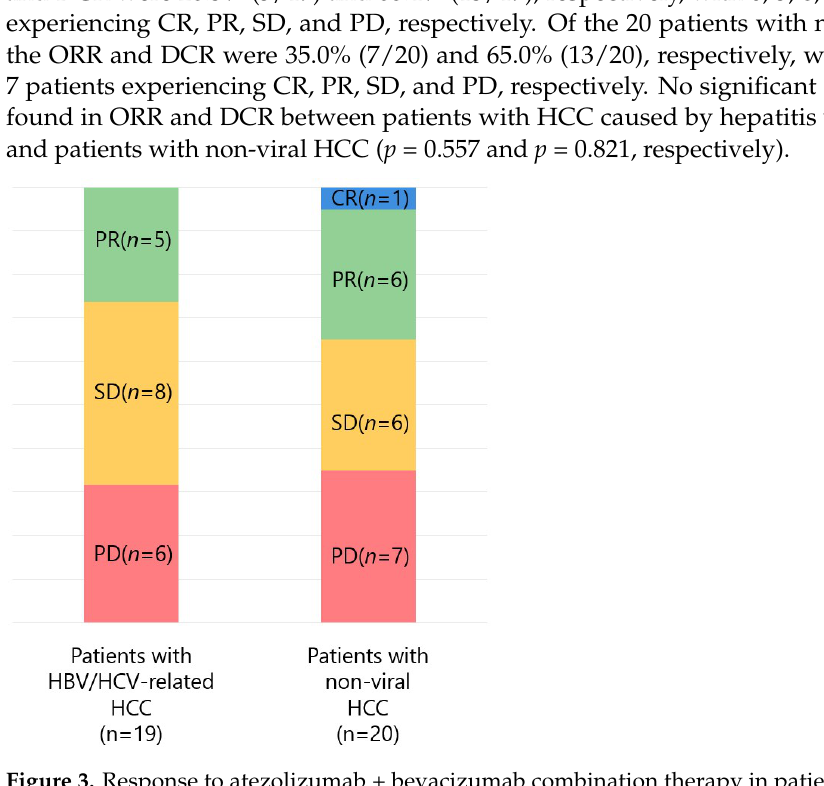
Figure 2. Response to atezolizumab + bevacizumab combination therapy divided by prior treat-